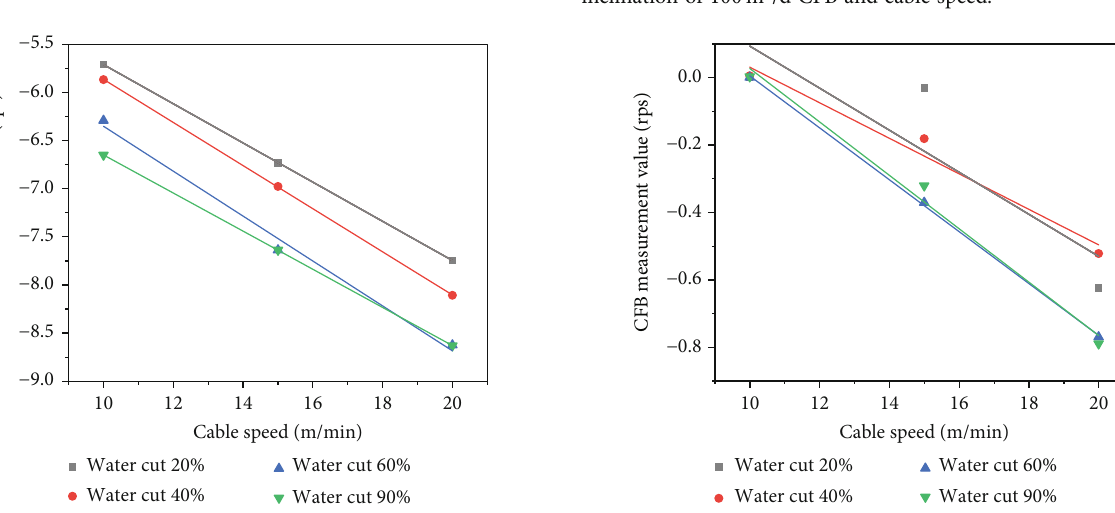
Figure 10: Relational graph of the measured value of 90 ° inclination of 100 m 3 /d CFB and cable speed.